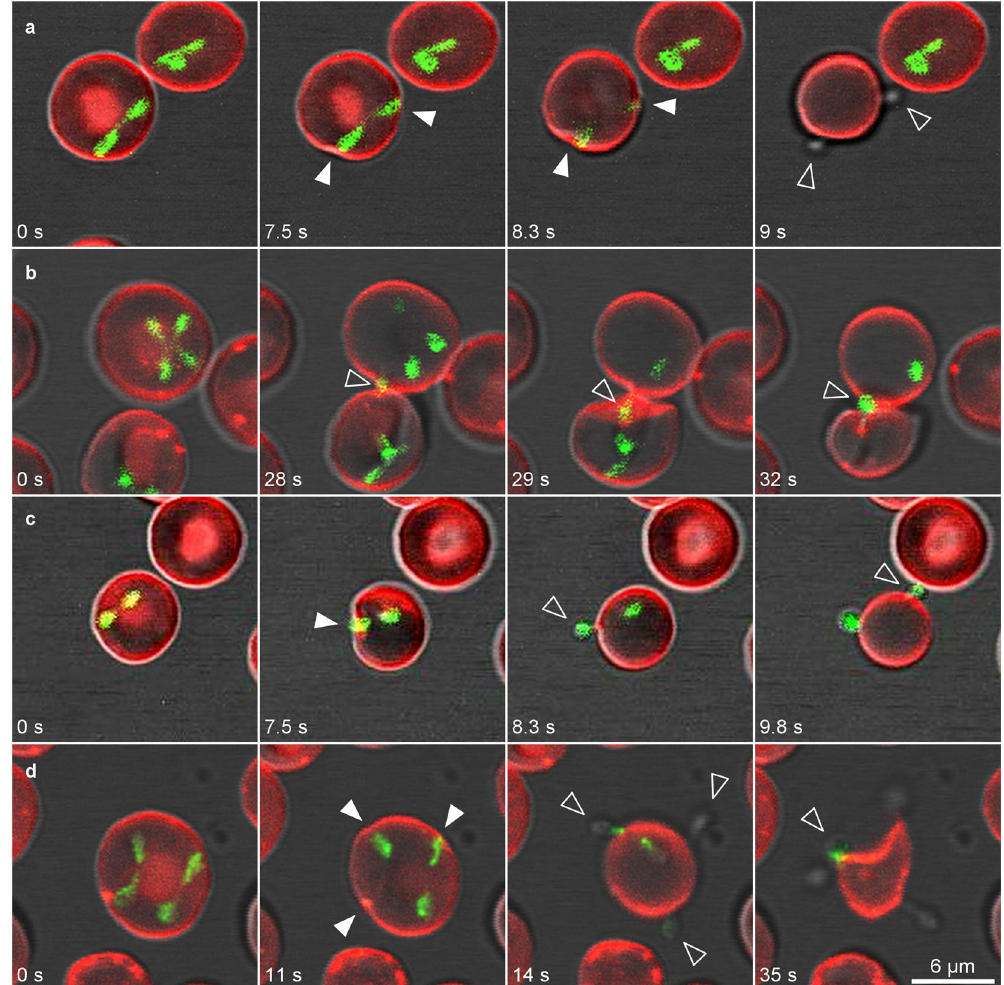
Figure 4. B. divergens merozoites exit the erythrocyte. Time-lapse image sequences of B. divergens parasites stained with MitoTracker (green fluorescent) and erythrocytes stained with PKH26 (red fluorescent). ( a ) A paired pyriform produces simultaneously depressions (white arrowheads) on two opposite sides of the erythrocyte plasma membrane at 7.5–8.3 s. Then, the two sister cells comprising the paired pyriform exert enough force in opposite directions to detach from each other and the detachment process results in two merozoites (arrowheads) in 8.3 s. Finally, both merozoites are simultaneously released from the opposite sides of the infected erythrocytes in 9 s. ( b ) An unattached merozoite from a tetrad touches the erythrocyte plasma membrane and is released (arrowhead) in 28 s following by two merozoites (arrowheads) that leave the cell from the same side in 29 s and 32 s, respectively. One merozoite remains within the erythrocyte. ( c ) Erythrocyte plasma membrane invagination (white arrowheads), causing by a paired pyriform at 7.5 s, facilitates the release of the two merozoites (arrowheads) from opposite sites. The first merozoite is released from the erythrocyte in 8.3 s and the second one in 9.8 s. ( d ) Two paired pyriforms (double paired pyriforms) simultaneously produces depressions on three different sides (white arrowheads) of the erythrocyte plasma membrane at 11 s. Then, four merozoites (arrowheads) are released from different sides at 14–35 s from the infected erythrocyte. Time-lapse imaging was captured every 0.753 or 1 s. The time-lapsed between each frame is indicated in